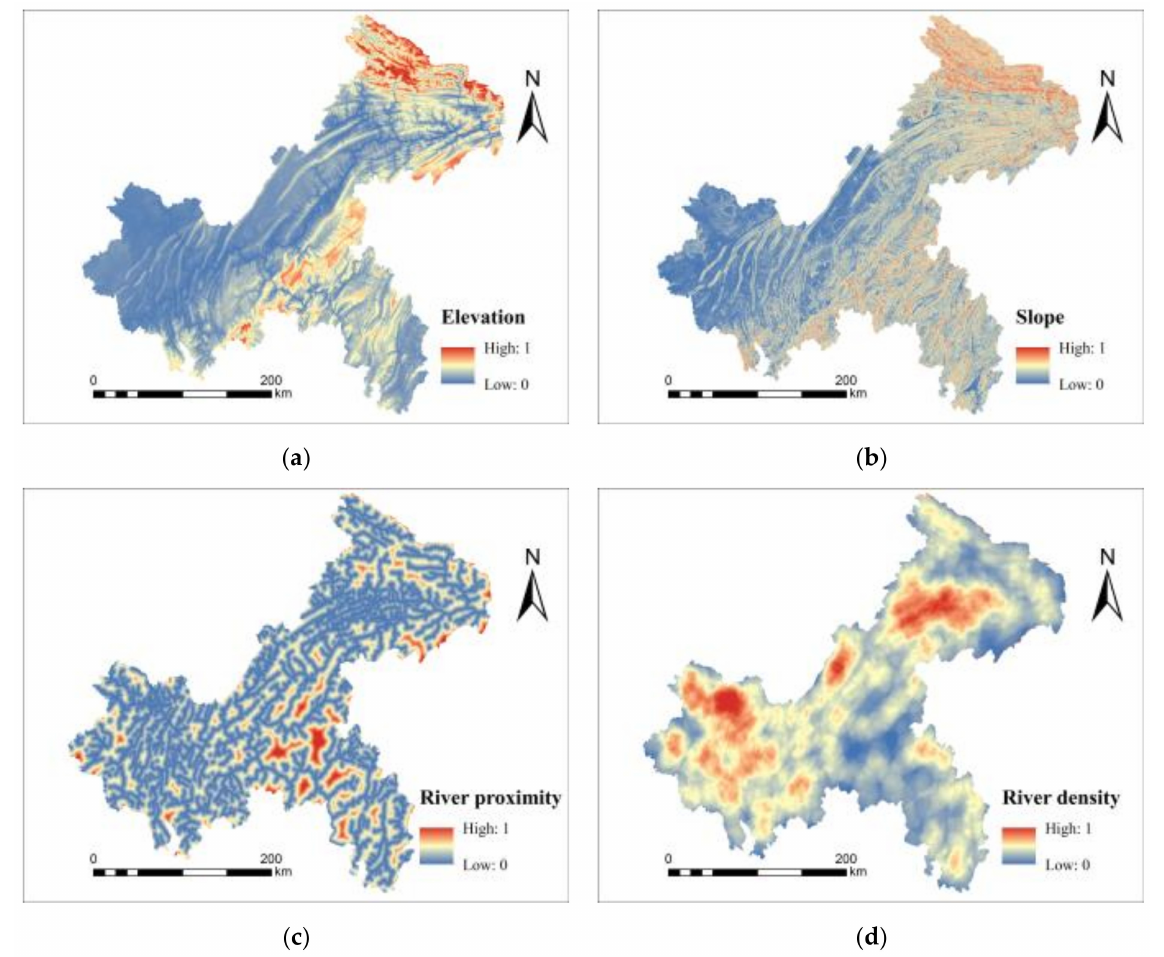
Figure 7. Spatial distribution map of normalized exposure data: ( a ) elevation, ( b ) slope, ( c ) river network proximity, ( d ) river network